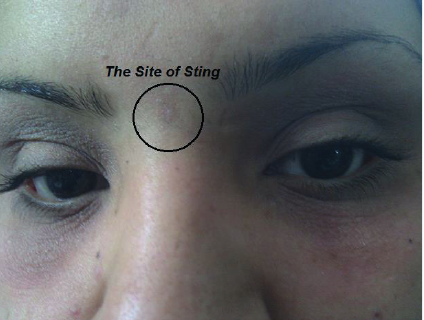
Figure 1: The site of sting in the patient with involved multiple cranial nerves 36 hours after